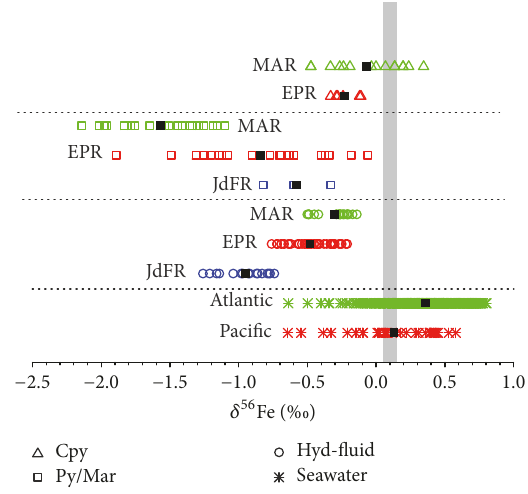
Figure 2: Fe isotopic composition of modern seafloor hydrothermal fluid and sulfide. (The gray color column shows the Fe isotope composition of basalt with an average value of + 0.11 ± 0.01 ‰ ( 𝑛 = 43 ) [10]; the black rectangle shows the average value of 𝛿 56 Fe. All data from the literatures is the same as Figure